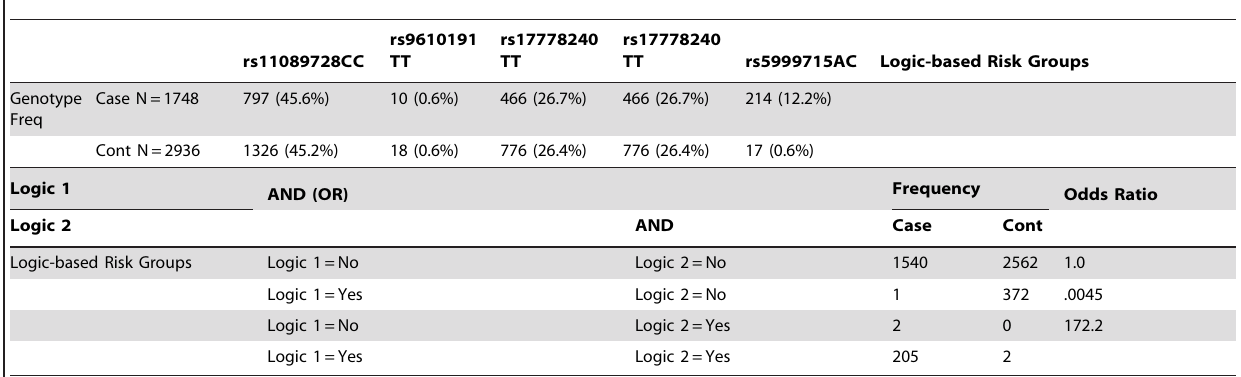
Table 2. Logic structures, frequencies, and associated Crohn’s Disease odds ratios of the ISX gene (p-value , 3.8 6 10 2 6